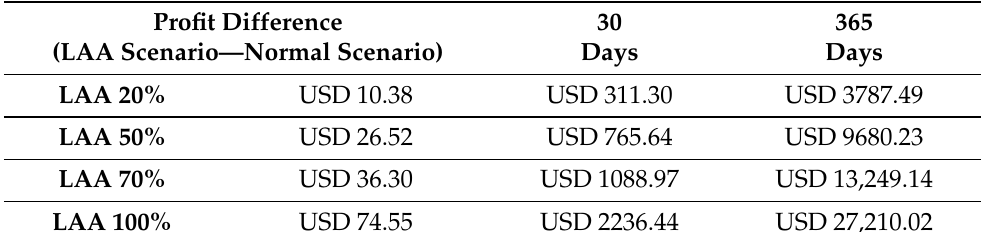
Figure 3. 24 h active power dispatch from transmission generators and active power flowing at the transmission–distribution boundary. The graphs on the left show the active power for the normal scenario where the ES system is optimized for energy arbitrage. The graphs on the right show the scenario where the LAA increases loads in the distribution system by 100%, and the ES system is optimized for energy arbitrage. Table 2. Profit difference between normal case study scenario and LAA